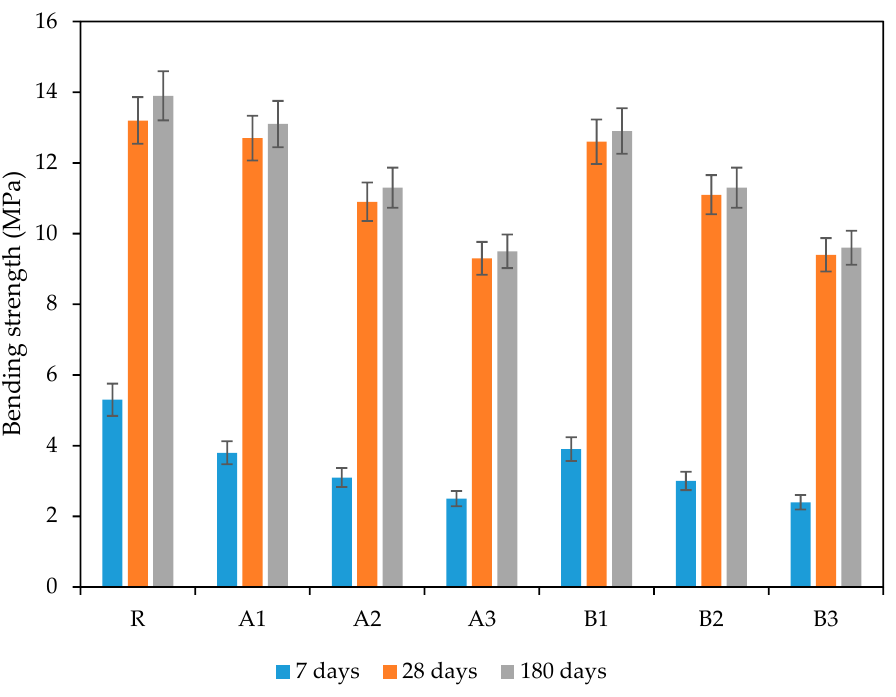
Figure 10. Time development of compressive strength.